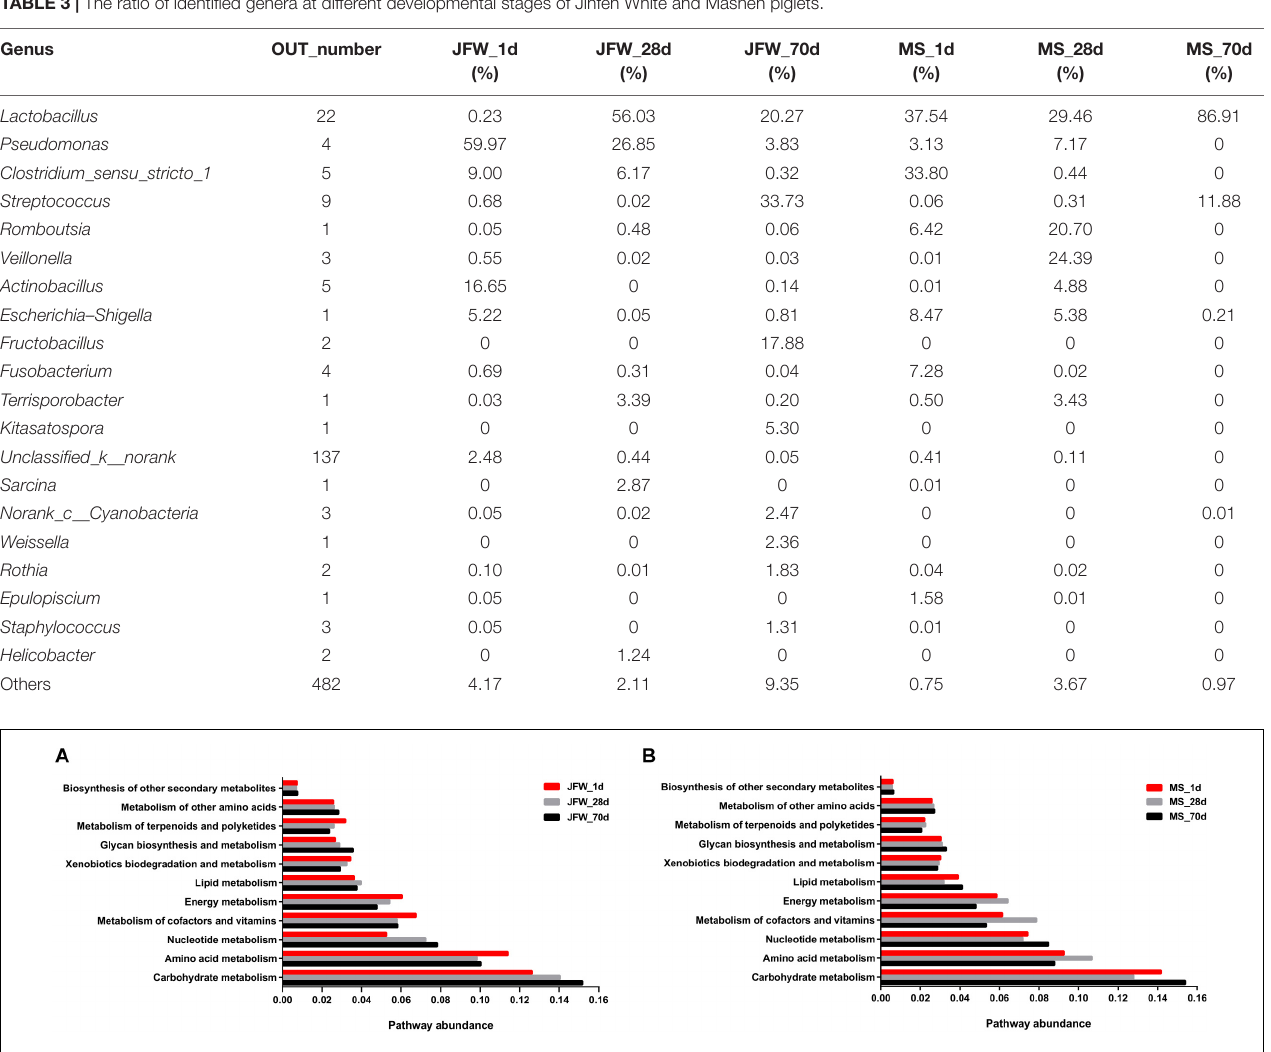
FIGURE 6 | The abundance of metabolic pathways in microorganisms from ileum. (A) The pathway abundance of Jinfen White piglets and (B) Mashen piglets.